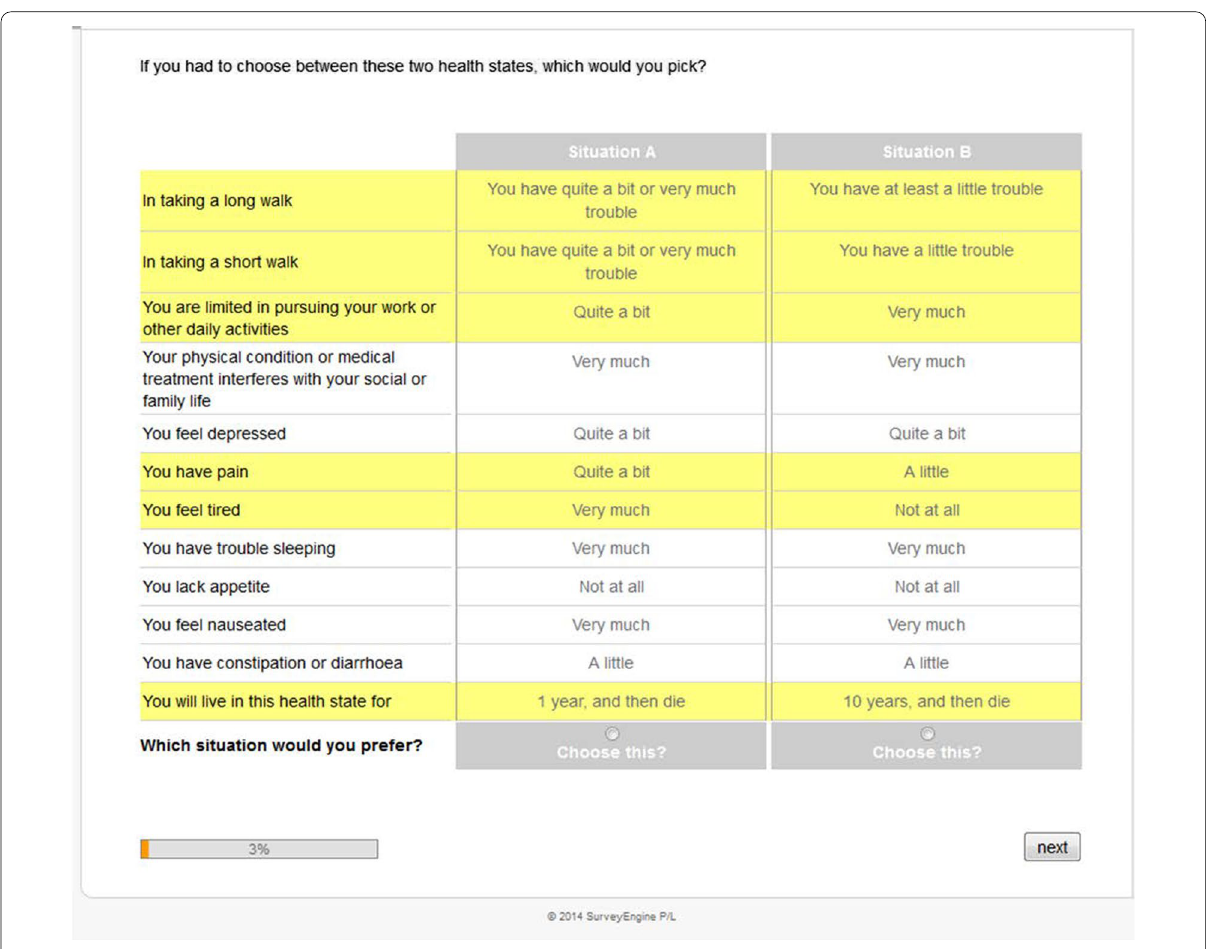
Fig. 1 Example DCE choice set form QLU‑C10D valuation